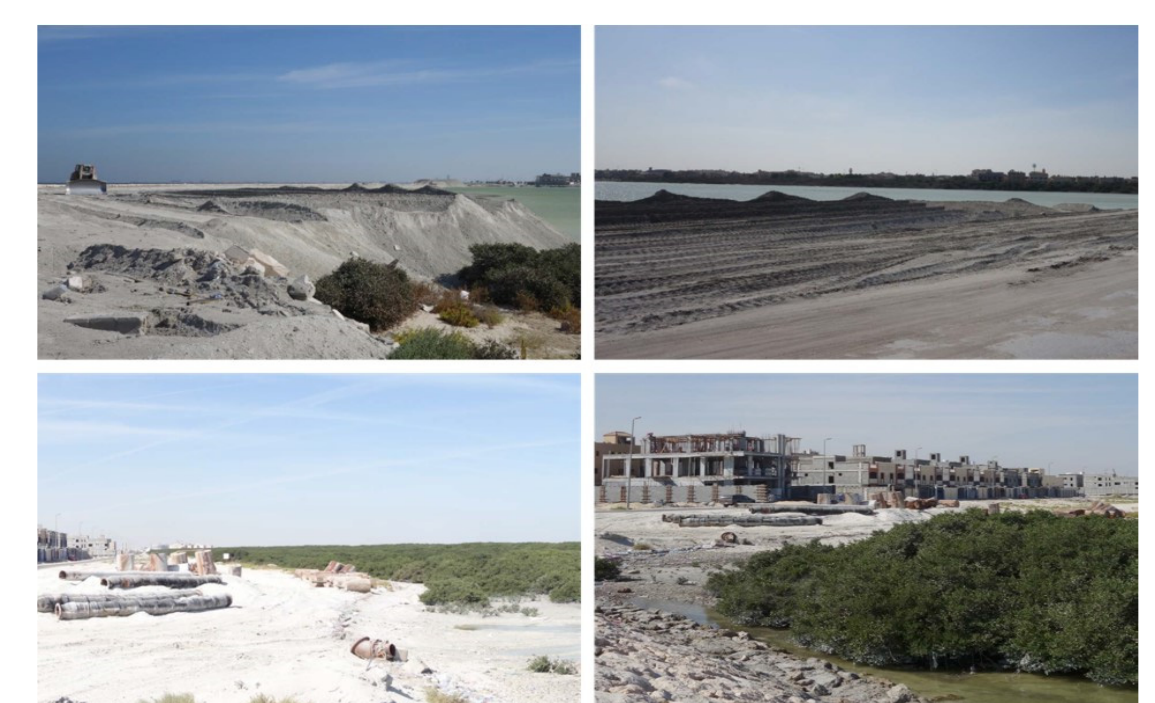
Figure 3. Examples of coastal land reclamation and destruction of mangrove forests in the study area (Source: [67]).